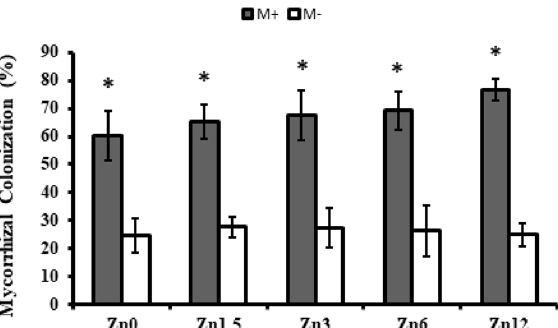
Figure 1. Effect of arbuscular mycorrhizal fungi inoculation on mycorrhizal colonization by maize under zinc deficient soil conditions Zn 0 (control), Zn 1.5 (1.5 mg kg -1 ), Zn 3 (3 mg kg -1 ), Zn 6 (6 mg kg -1 ), Zn 12 (12 mg kg -1 ), inoculated with AMF (M + grey), un-inoculated (M- white). Error bars represent standard error. Inoculated with AMF (M + grey); un-inoculated (M-